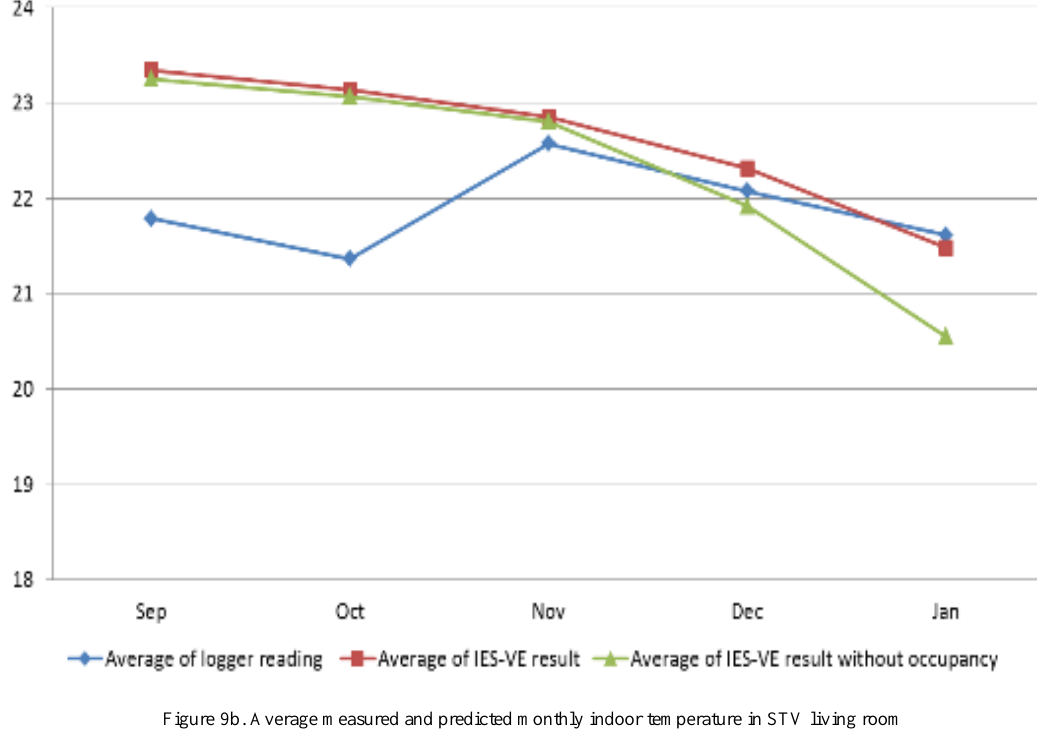
Figure 9b. Average measured and predicted monthly indoor temperature in STV living room